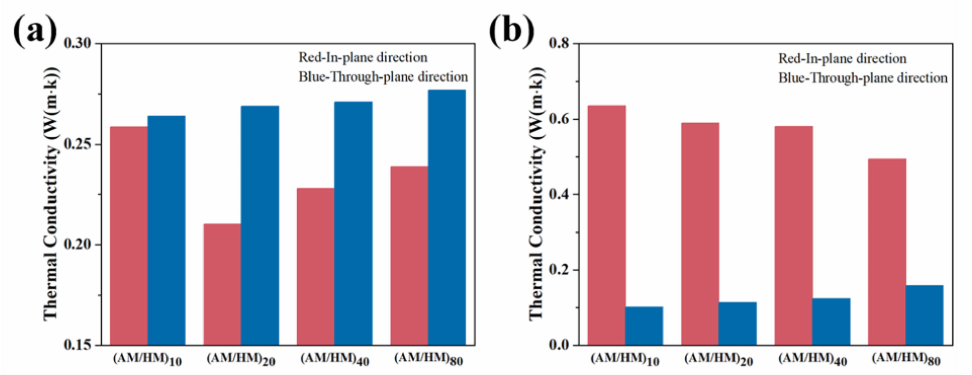
Figure 9. The in-plane and through-plane thermal conductivity of AH layer ( a ) and HM layer ( b